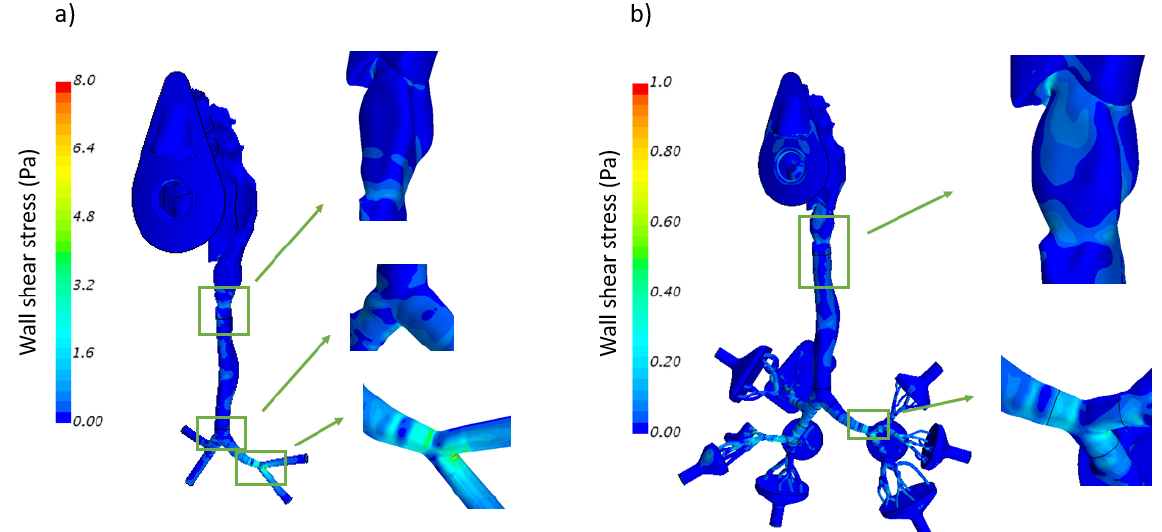
Fig. 5. Contours of wall shear stress in a) child and b) adult